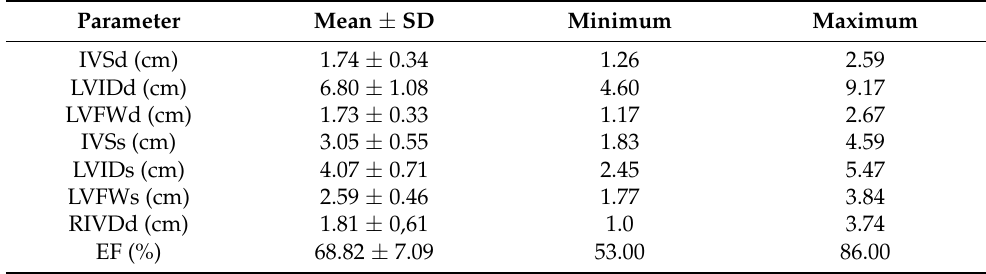
Table 2. Echocardiographic parameters in Pega breed donkeys from the M-mode of the LV and the short axis view of the LA and aorta (mean, standard deviation, minimum and